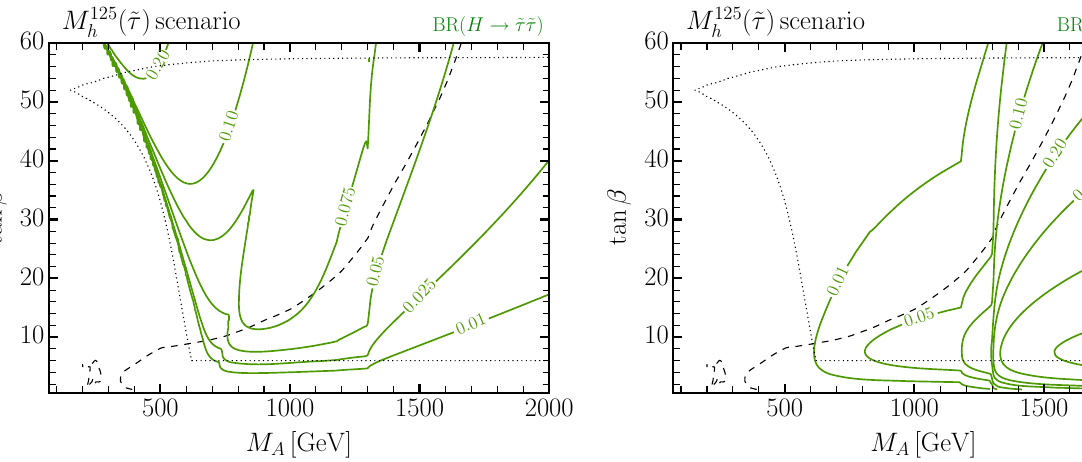
Fig. 4 Left: Total branching ratio for the decays of the heavier CP - even scalar H into stau pairs, as a function of M A and tan β in the ( ˜ τ) scenario. Right: same as the left plot for the total branching M 125 h